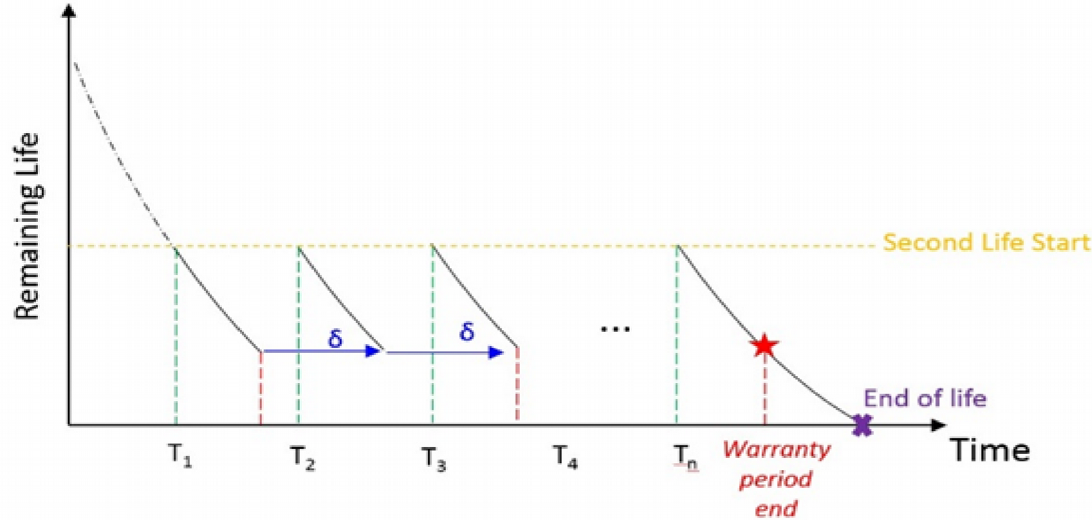
Figure 3. Scheme for PM policies for remanufactured